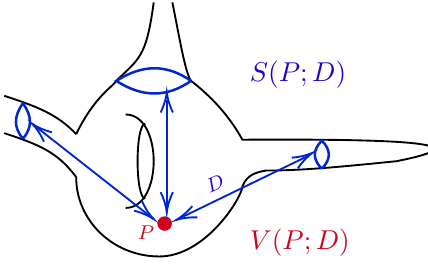
Figure 1 . Illustration of V ( P ; D ) and S ( P ; D ) . Here V ( P ; D ) is the set of points whose geodesic distance from P is less than or equal to D . The boundary of V ( P ; D ) is denoted by S ( P ; D ) . In the figure, S ( P ; D ) consists of three